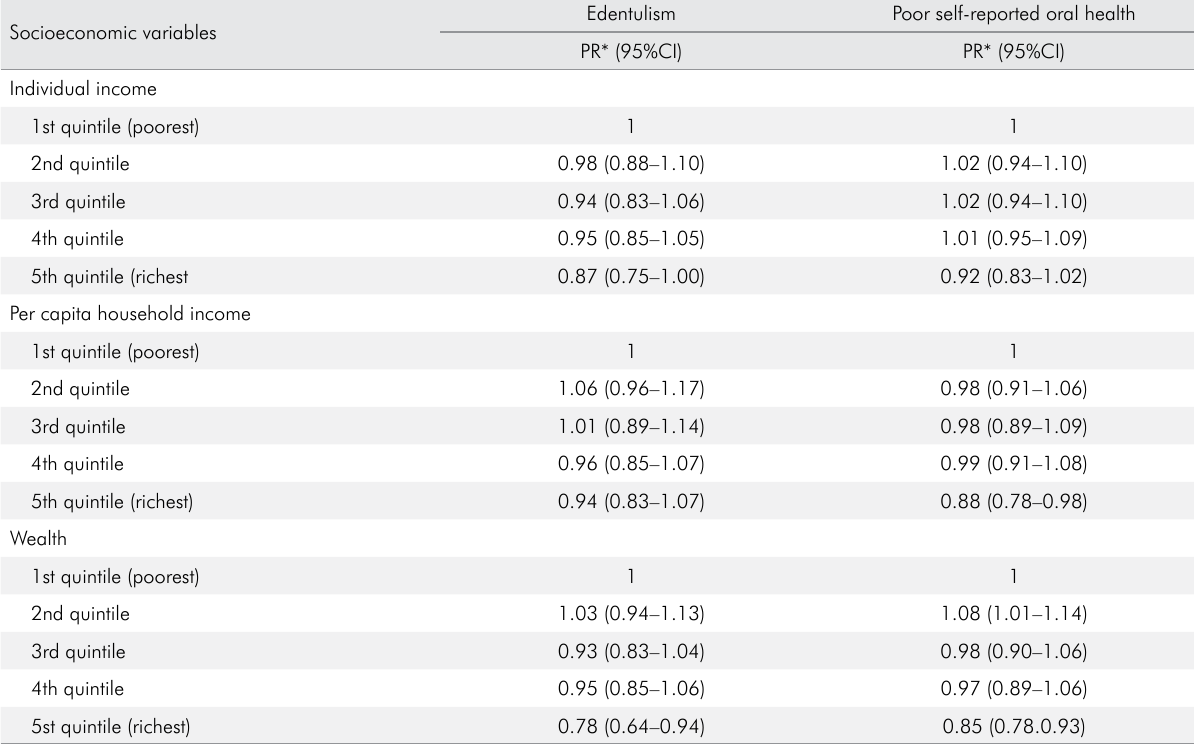
Table 3. Weighted adjusted prevalence ratios of socioeconomic variables with edentulism and poor self-perception of oral health among older adults at baseline of the Brazilian Longitudinal Study of Aging, using Poisson regression